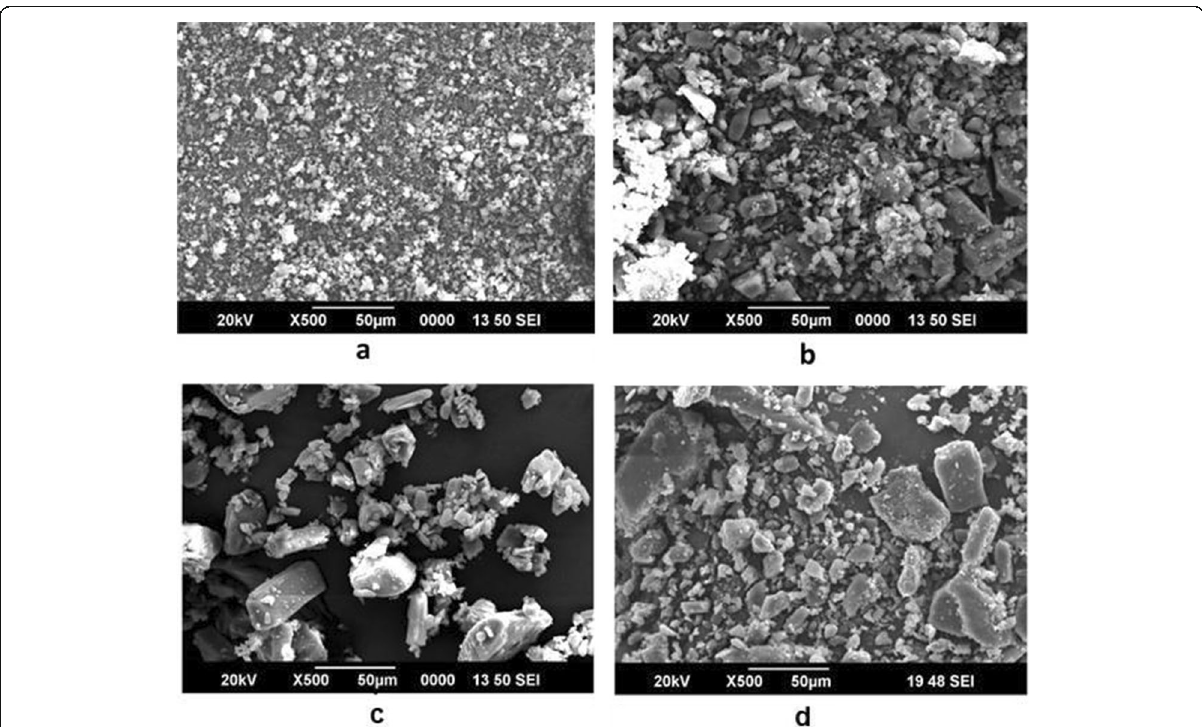
Fig. 4 SEM images of a pure GLZ, b GLZ – DNS, c GLZ – LPN, and d GLZ – PDA